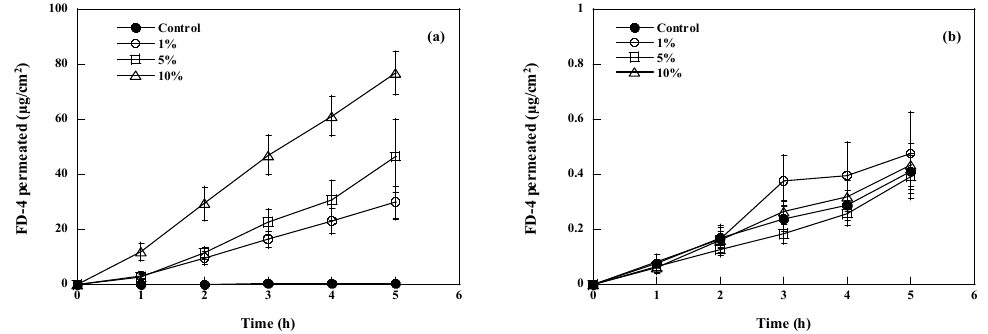
Figure 1. Effect of fatty acid concentration (capric acid, panel ( a ); stearic acid, panel ( b )) on the permeation of FD-4 across pig esophageal epithelium, compared to the control (ethanol pretreatment). Mean values ± SEM. Table 2 . Effect of type and concentration of fatty acid on the permeation parameters of FD-4 across pig esophageal epithelium (mean values ± SEM).